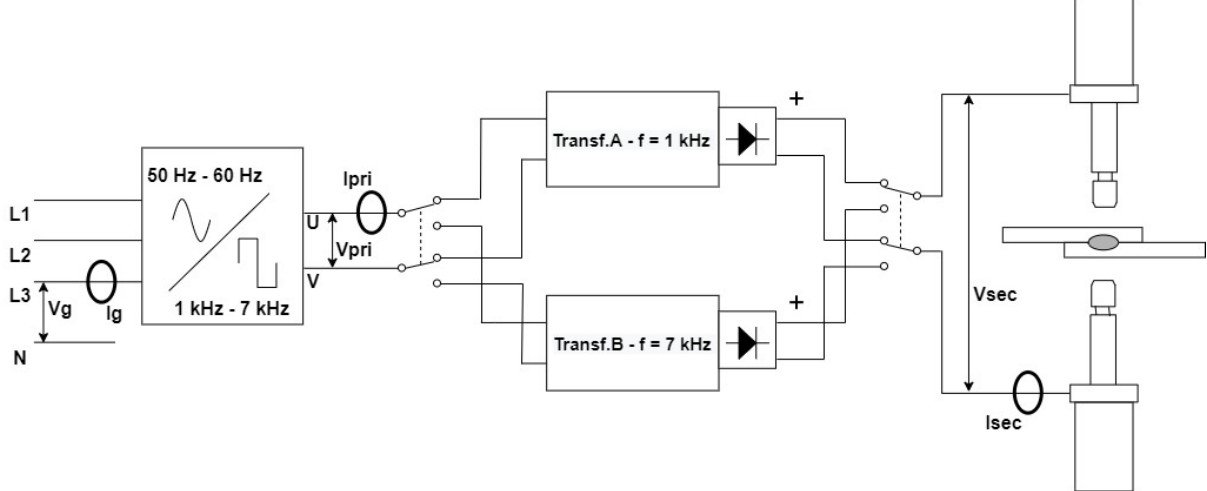
Figure 1. Schematic of the welding equipment used in the experiments.